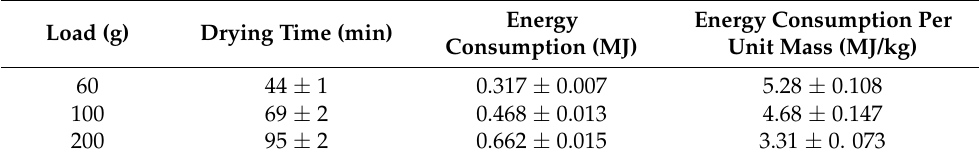
Figure 7. Microwave drying temperature of corn with different loads. Table 3. Microwave drying energy consumption of corn in different loads.